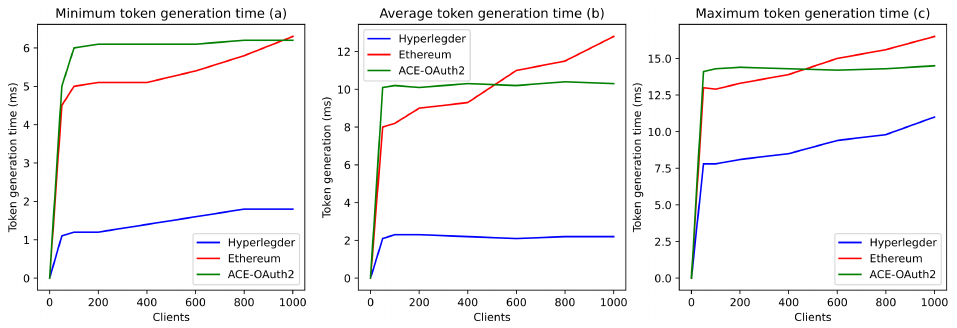
Figure 10. Token generation time by the blockchain and a Classic ACE-OAuth